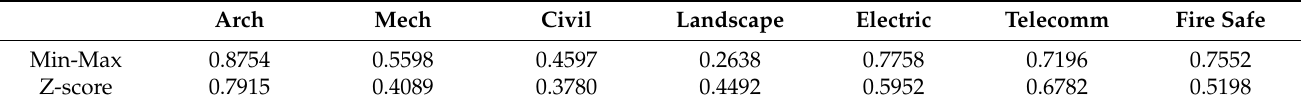
Table 8. R-Square of sub cost